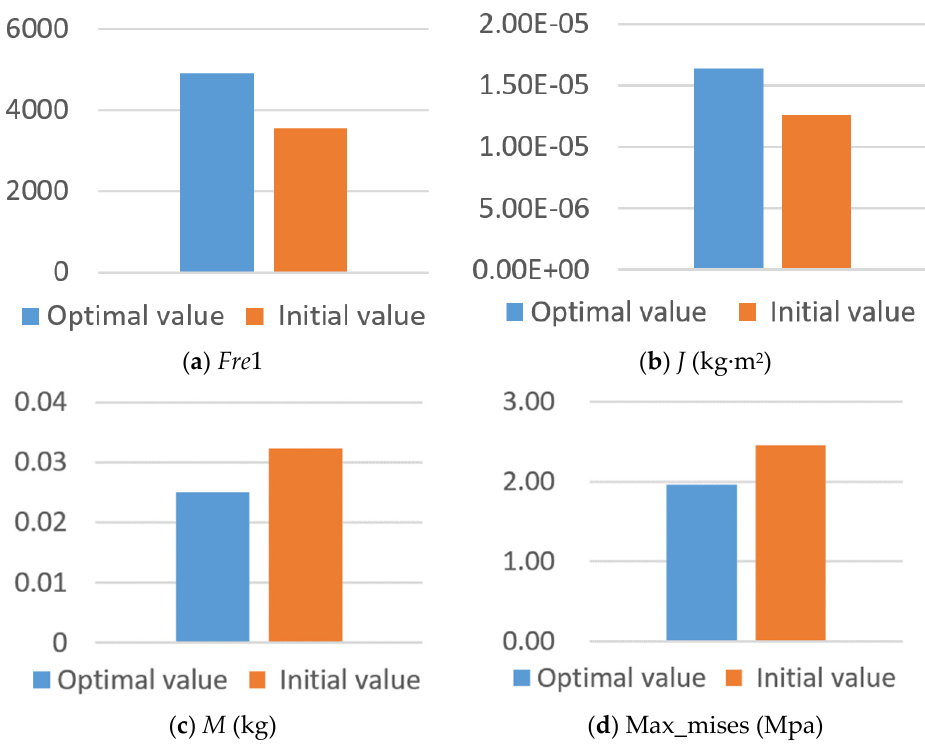
Figure 11. Optimised